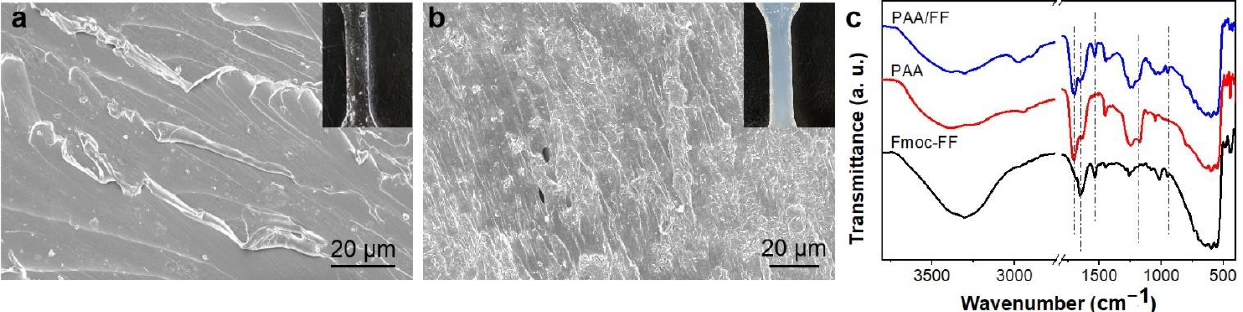
Figure 1. SEM images of ( a ) PAA gel, ( b ) PAA/FF gel; ( c ) the FTIR spectra of Fmoc-FF, PAA, and PAA/FF gels.